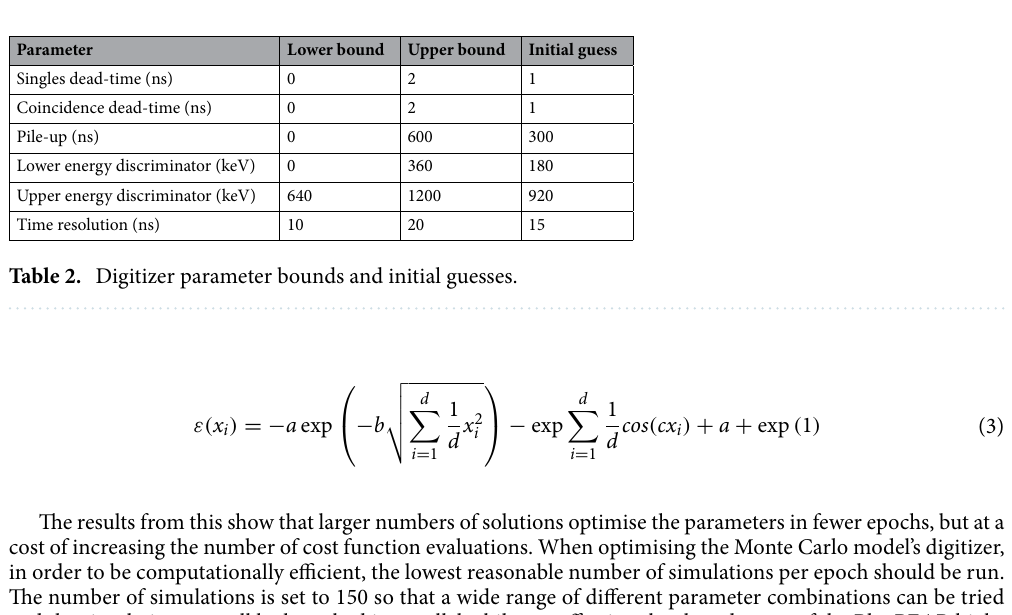
Figure 6. ( a ) The two-dimensional Ackley function with the with evaluation as the third dimension. ( b ) The behaviour of the number of epochs needed to find the global minimum as well the total number of cost functions evaluated as function of the number of solutions per epoch.